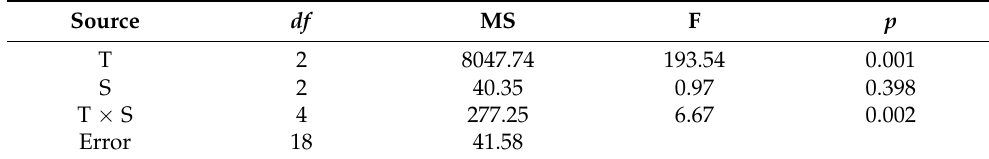
Table 3. MANOVA results using a generalized linear model for the main and interaction effects of temperature and salinity on Perna viridis survival rates.